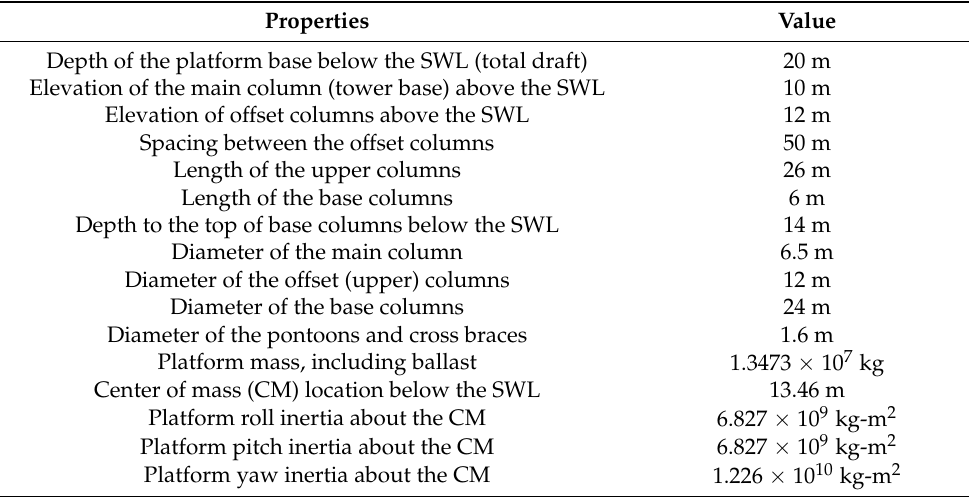
Figure 2. ( a ) Conceptual drawing of the OC4-DeepCwind semi-submersible floating wind turbine and ( b ) blade numbering.